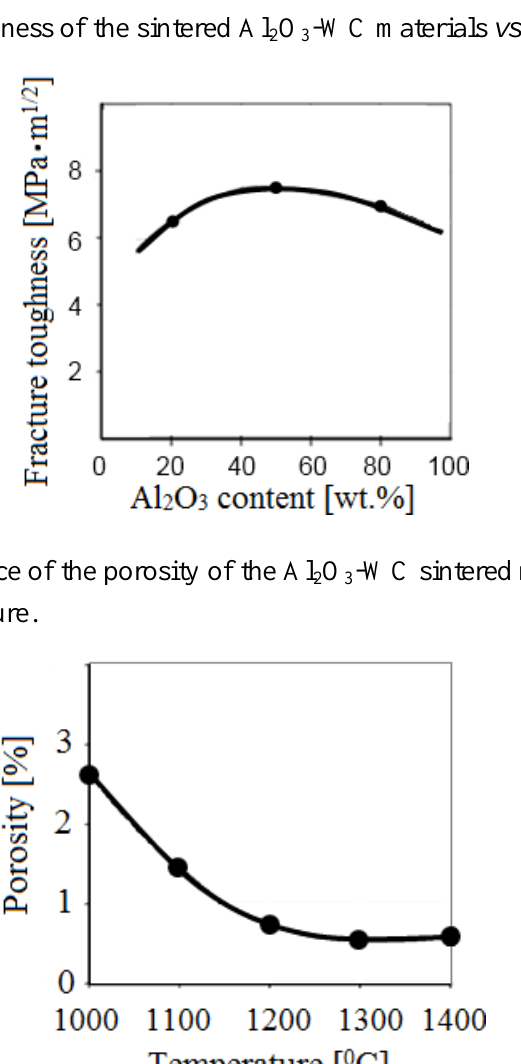
О -WC composite 2 3